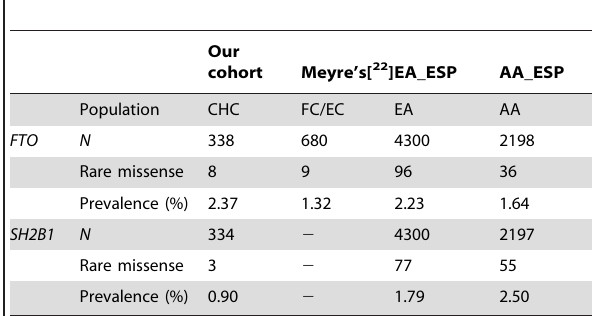
Table 3. Difference on prevalence of FTO rare non- synonymous mutation between boys and girls with obesity.